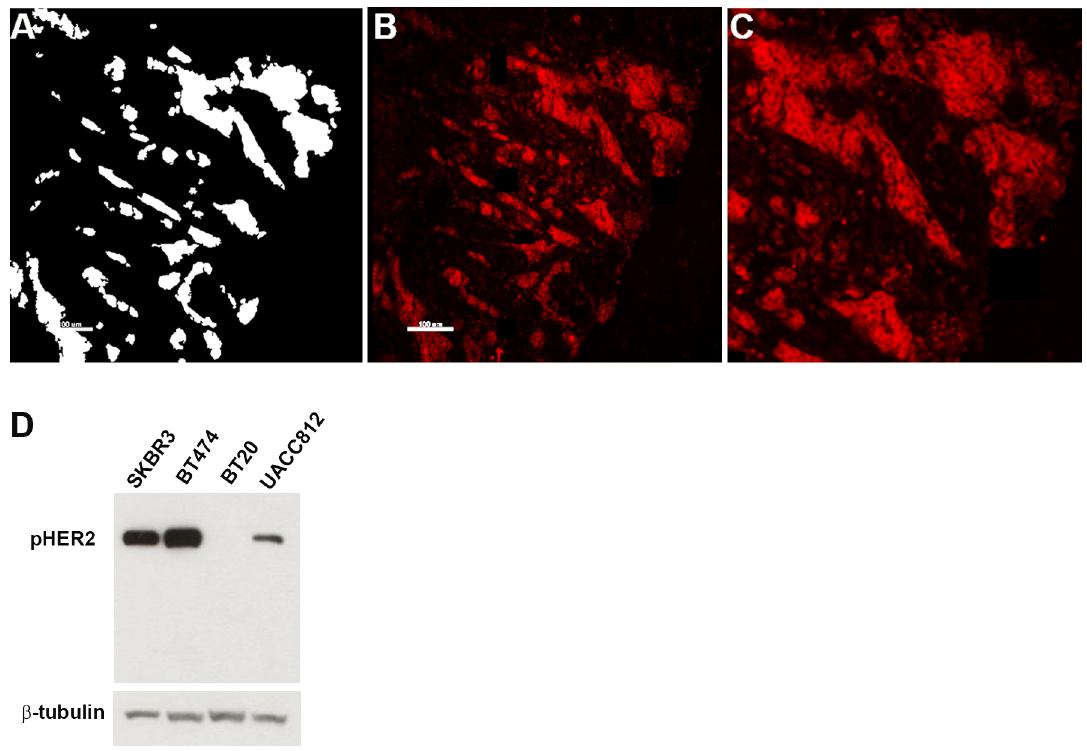
Figure 3. Fluorescent pTyr 1248 HER2 IHC in control arrays and antibody validation. A: Assignment of the tumor compartment as defined by cytokeratin and DAPI detection in sections with invasive or DCIS lesions. B : Representative immunofluorescent detection of pTyr 1248 HER2. Original magnification, 20 6 . C : pTyr 1248 HER2 with high magnification. D : phosphoTyr 1248 HER2 was detected by Western blot in quiescent cell cultures. b - tubulin was used as a loading control.